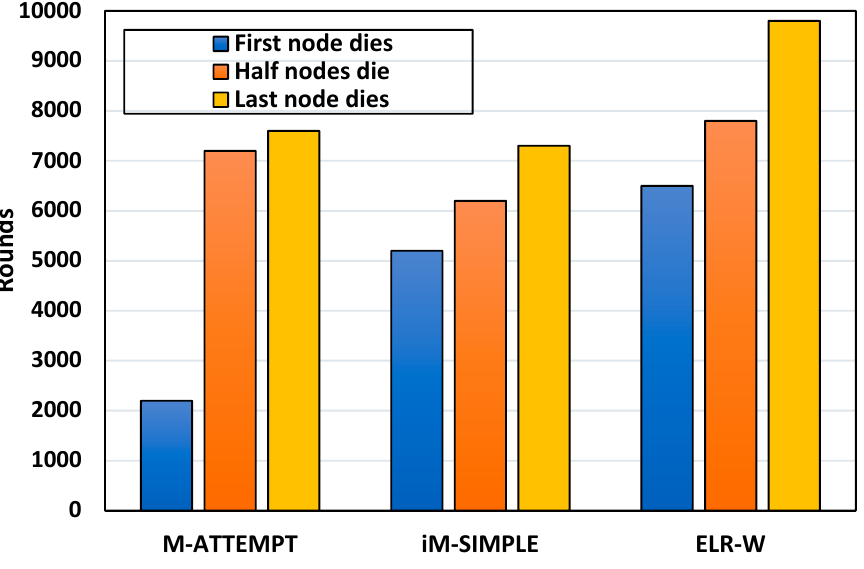
Figure 5. Analysis of network lifetime.